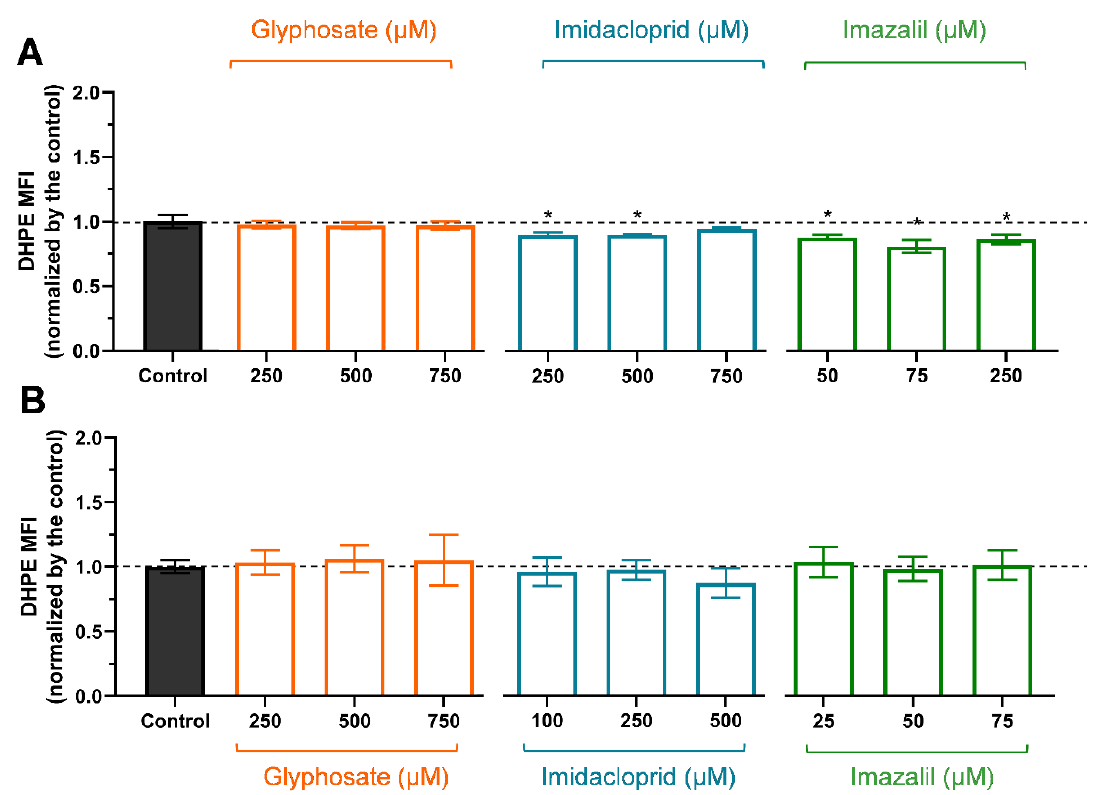
Figure 4. Assessment of lipid peroxidation in Caco-2 ( A ) and in HepG2 ( B ) cells exposed to GLY, IMD, and IMZ, for 24 h, using flow cytometry and DHPE-FITC probe. Results were normalized to control (non-exposed cells) and are presented as mean ± SD ( n = 3 independent experiments). Significant statistical differences between the control and samples are denoted by “*” when p < 0.05.